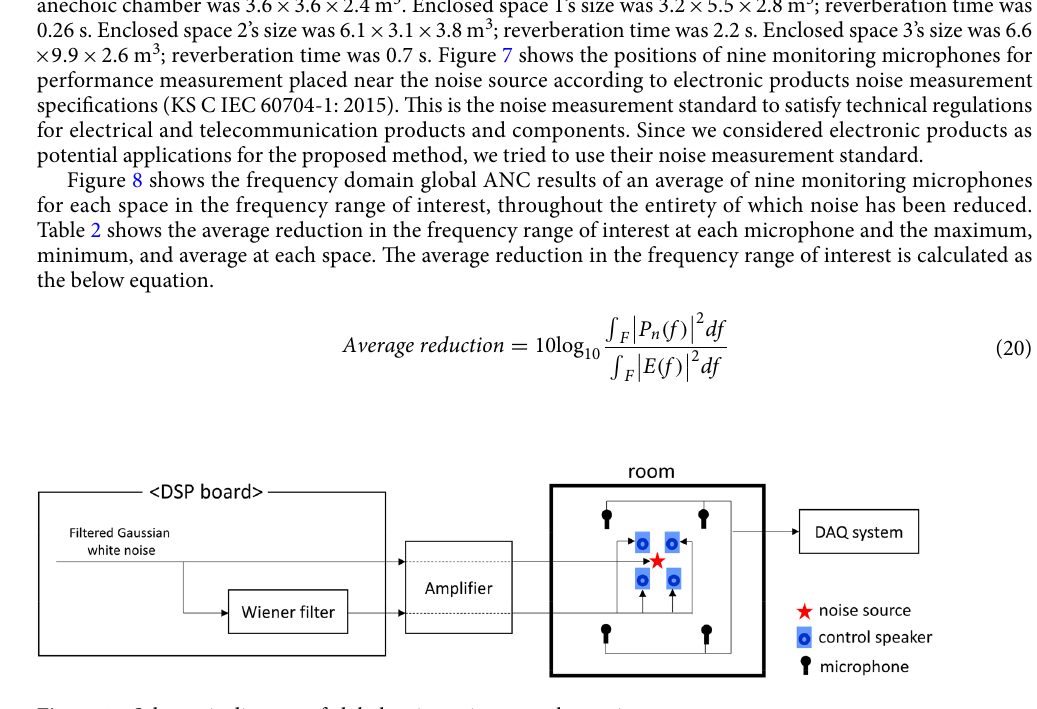
Figure 5. Schematic diagram of global active noise control